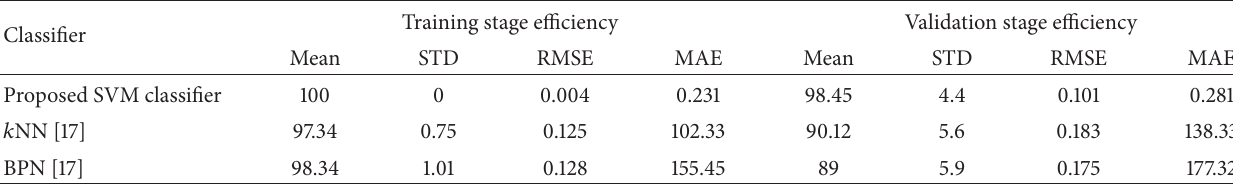
Table 4: Performance of the